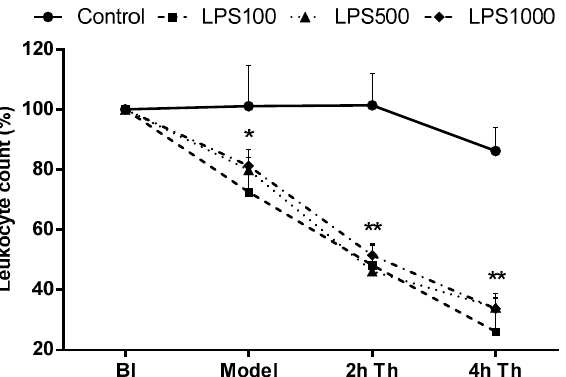
Figure 4. Total leukocyte count in arterial blood before instillation (BI) of saline (Control) or different doses of lipopolysaccharide (LPS100, 500, and 1000 µ g / kg), 1 h after instillation (Model) and therapy (Th) administration during 4 h of experiment, expressed as a percentage (%). Control vs. LPS-treated groups * p < 0.05, ** p < 0.01.